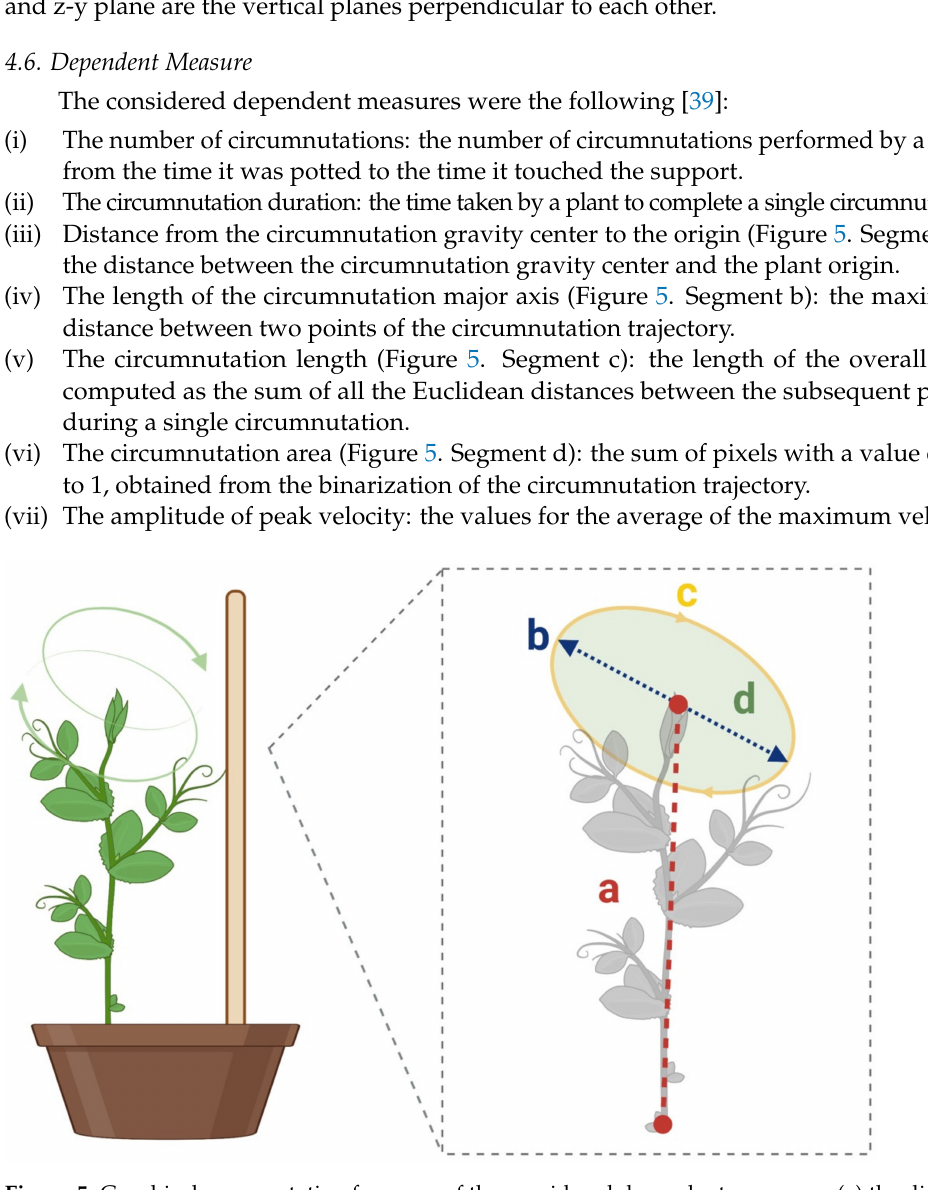
Figure 5. Graphical representation for some of the considered dependent measures: ( a ) the distance from the circumnutation gravity center to the origin is represented as a red/dash line; ( b ) the length of the circumnutation major axis is represented as a blue/dash line; ( c ) the circumnutation length is represented as a yellow/solid line; ( d ) the circumnutation area is represented in